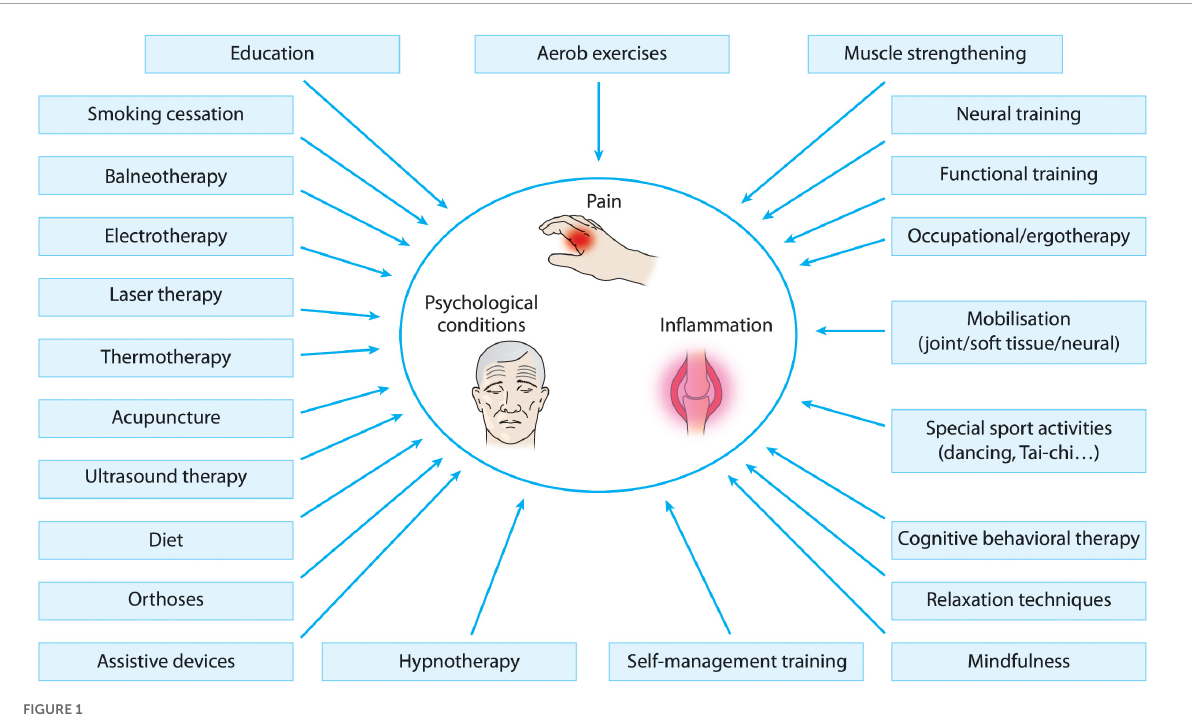
FIGURE1 Different non-pharmacological treatment options in